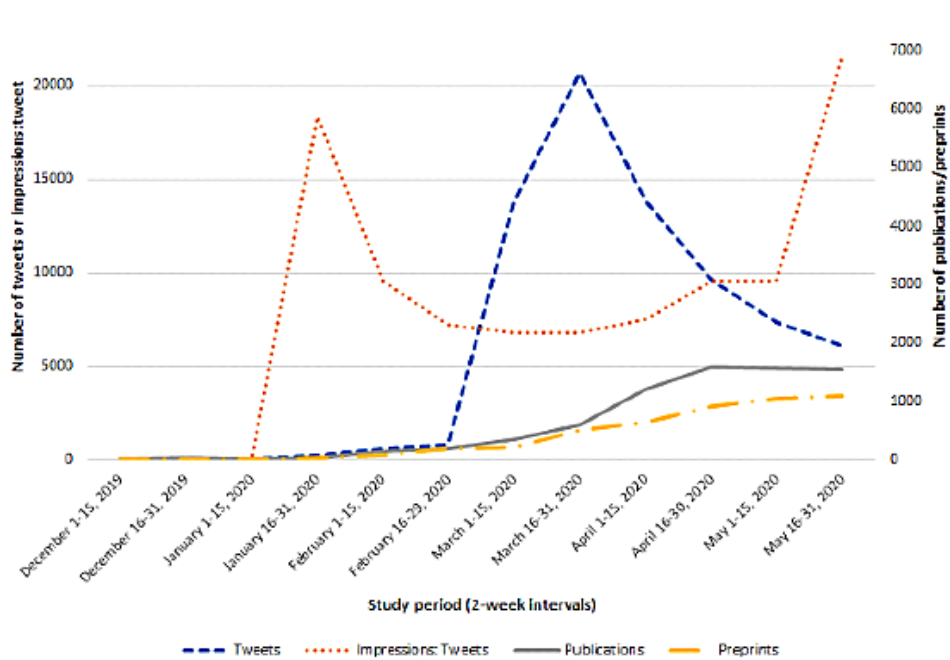
Figure 2. Trend of COVID-19–related tweets, ratio of impressions to tweets, publications and preprints. Twitter activity from December 1, 2019, through May 31, 2020, captured at half-month intervals by using the Twitter analytics platform Symplur Signals. Preprints from medRxiv and bioRxiv repositories were also abstracted during this time period along with publications indexed in the PubMed-NCBI database.